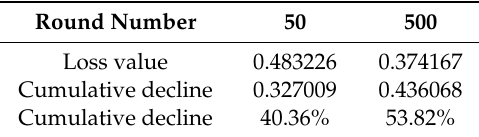
Figure 10. Loss curve after 500 training rounds. Table 2. Statistical table of the loss decline.